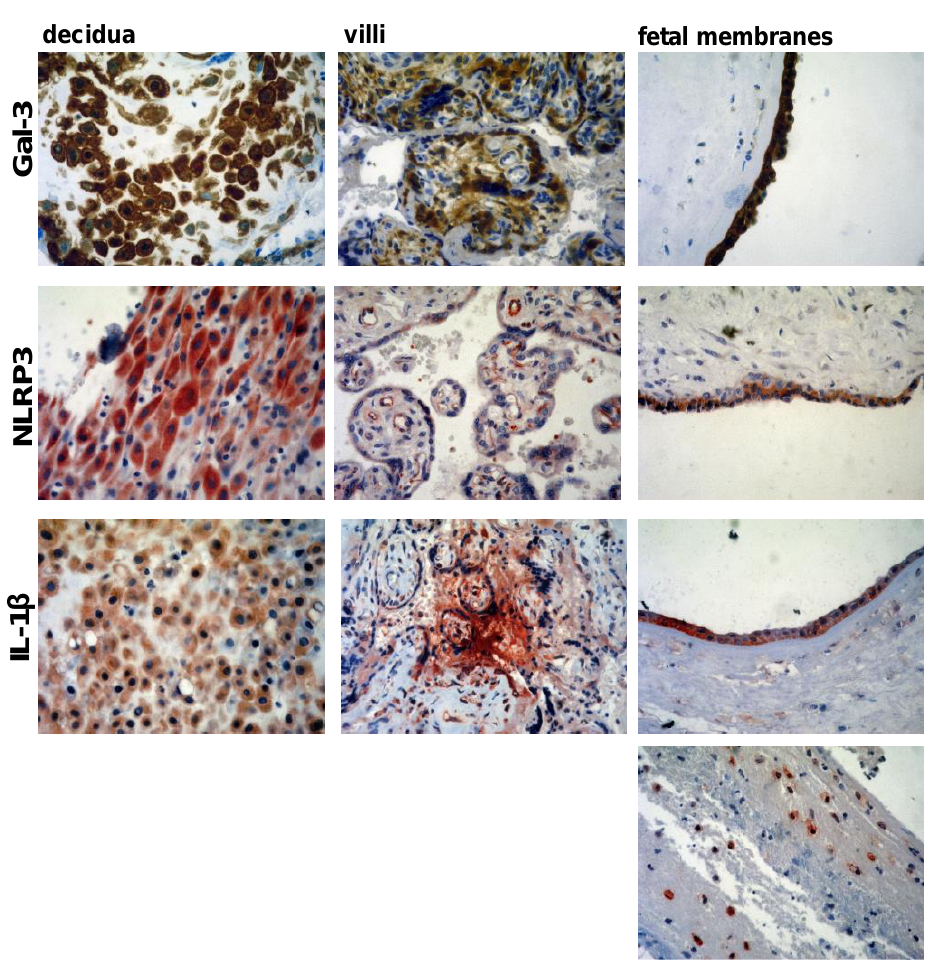
Figure 5. Gal-3, IL-1 β , and NLRP3 staining of decidual, amniotic, and trophoblast cells in decidua, villi, and fetal membranes tissues which were obtained during preterm births (magnification 400×).